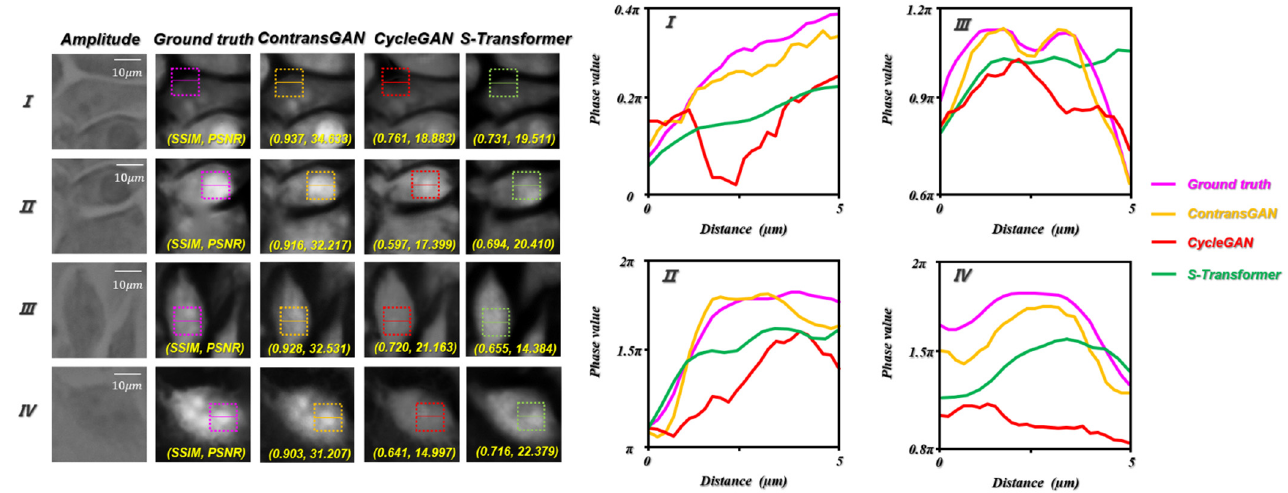
Figure 9. Test results of Hela cells by the CycleGAN-Hela and S-Transformer. SSIM and PSNR